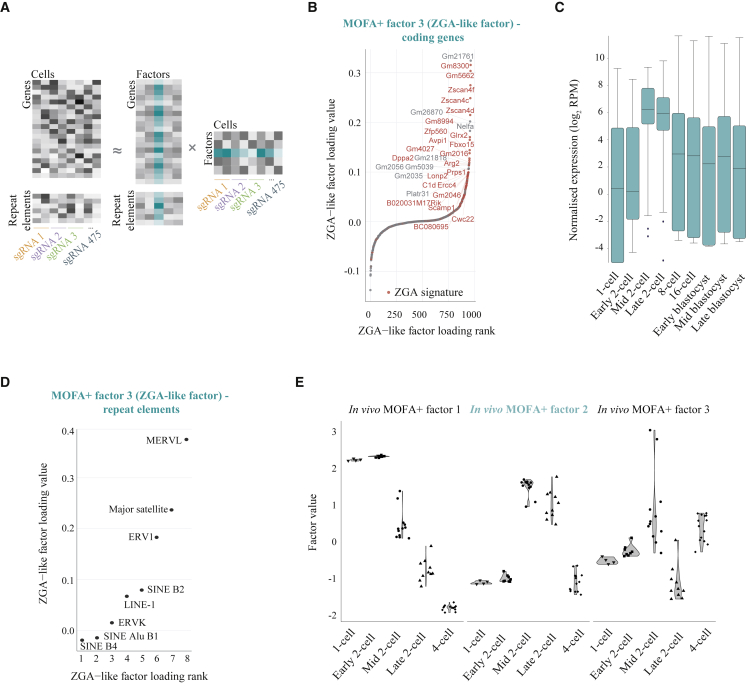
Identification of a ZGA-like Transcriptional Signature Using MOFA+(A) Schematic of the joint analysis of coding gene and repeat element expression using multi-omics factor analysis (MOFA+). Data matrices of dimension features (genes or repeat elements) in cells grouped by sgRNA expression are treated as distinct views in the model and decomposed into the product of weights (or loadings) and factors. Factor 3 in the trained model, interpreted as a ZGA-like factor, is highlighted in green.(B) Coding genes ranked by their loadings of MOFA+ factor 3, highlighting in red previously known ZGA genes (as described in Table S2; see also Table S4 for gene loading values), indicating that this factor captures a ZGA-like response, and thus, identifying it as a MOFA+ ZGA-like factor.(C) Box-whisker plots showing normalized expression levels (log2 reads per million; RPM) for the top 50 gene loadings of MOFA+ factor 3 (ZGA-like factor) during preimplantation development (data analyzed from Deng et al. (2014) (see Table S4 for gene loadings).(D) Repeat element families ranked by their loadings of MOFA+ factor 3 (ZGA-like factor).(E) Violin plots for MOFA+ factor values 1–3 trained on scRNA-seq data for zygotes, early two-cell, mid two-cell, late two-cell, and four-cell stage embryos (data analyzed from Deng et al., 2014).